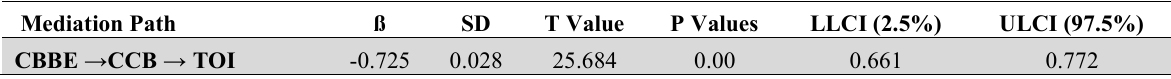
Mediation Analysis Mediation